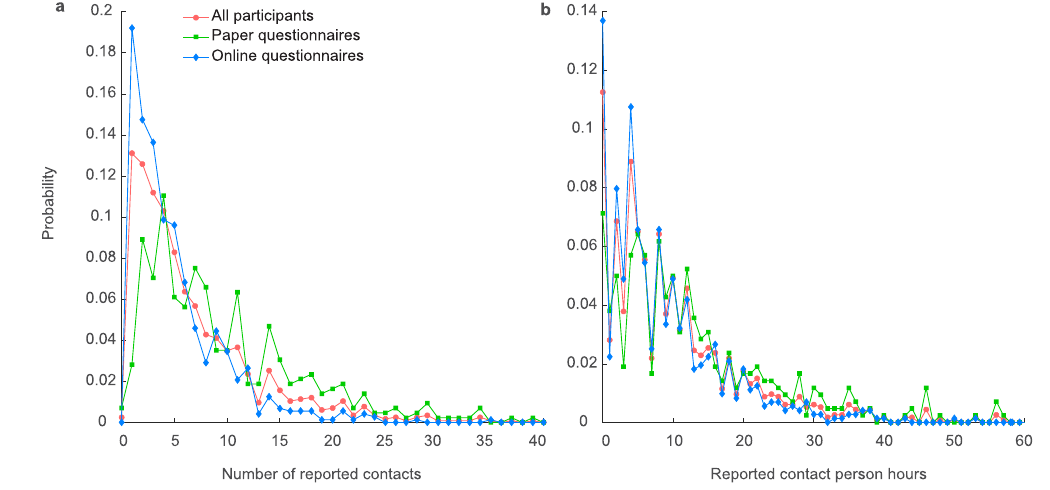
Figure 1. The distribution of the number of reported contacts and total contact